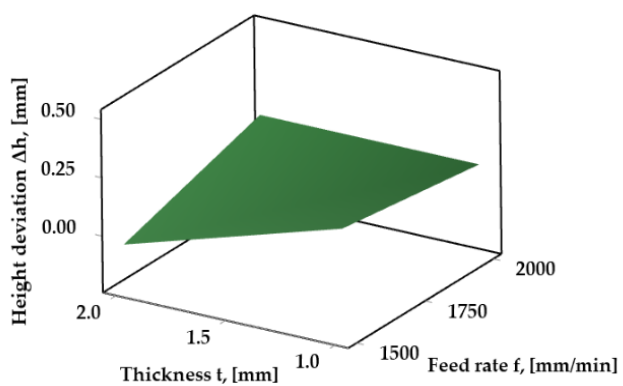
Figure 12. Influence exerted by the workpiece thickness t and feed rate f on the height deviation Δ h when using a cryogenic agent ( s d = 0.7 mm).